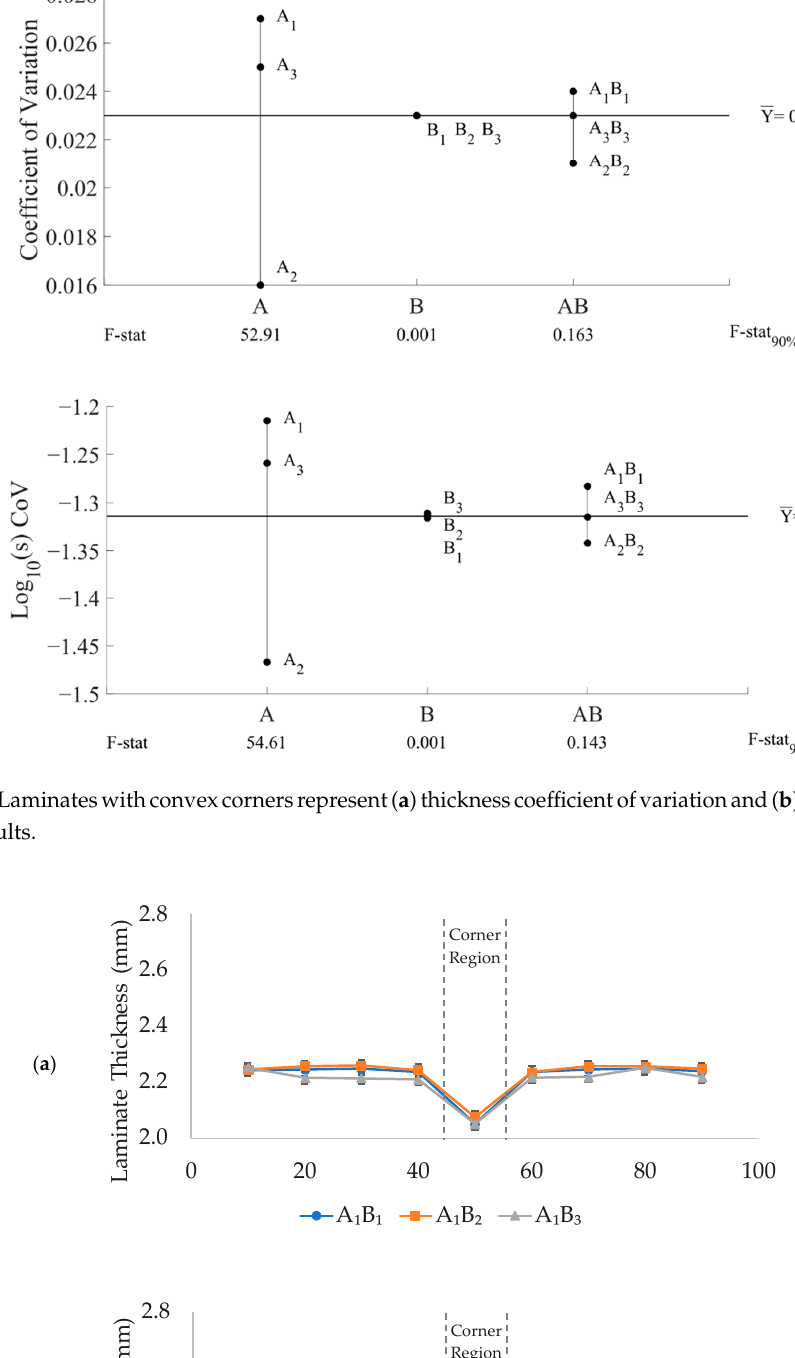
( c ) Figure 8. Thickness across the length of laminates with concave corner produced using ( a ) SVB, ( b ) MSVB, and ( c ) DVB techniques. 3.2. Spring Effect of Laminated Composites Consistency for the laminated composite to retain the original shape without any spring-forward or spring-back after curing is highly sought by composite manufacturers. A significantly large amount of residual stresses in laminated composites are likely to develop during the curing process